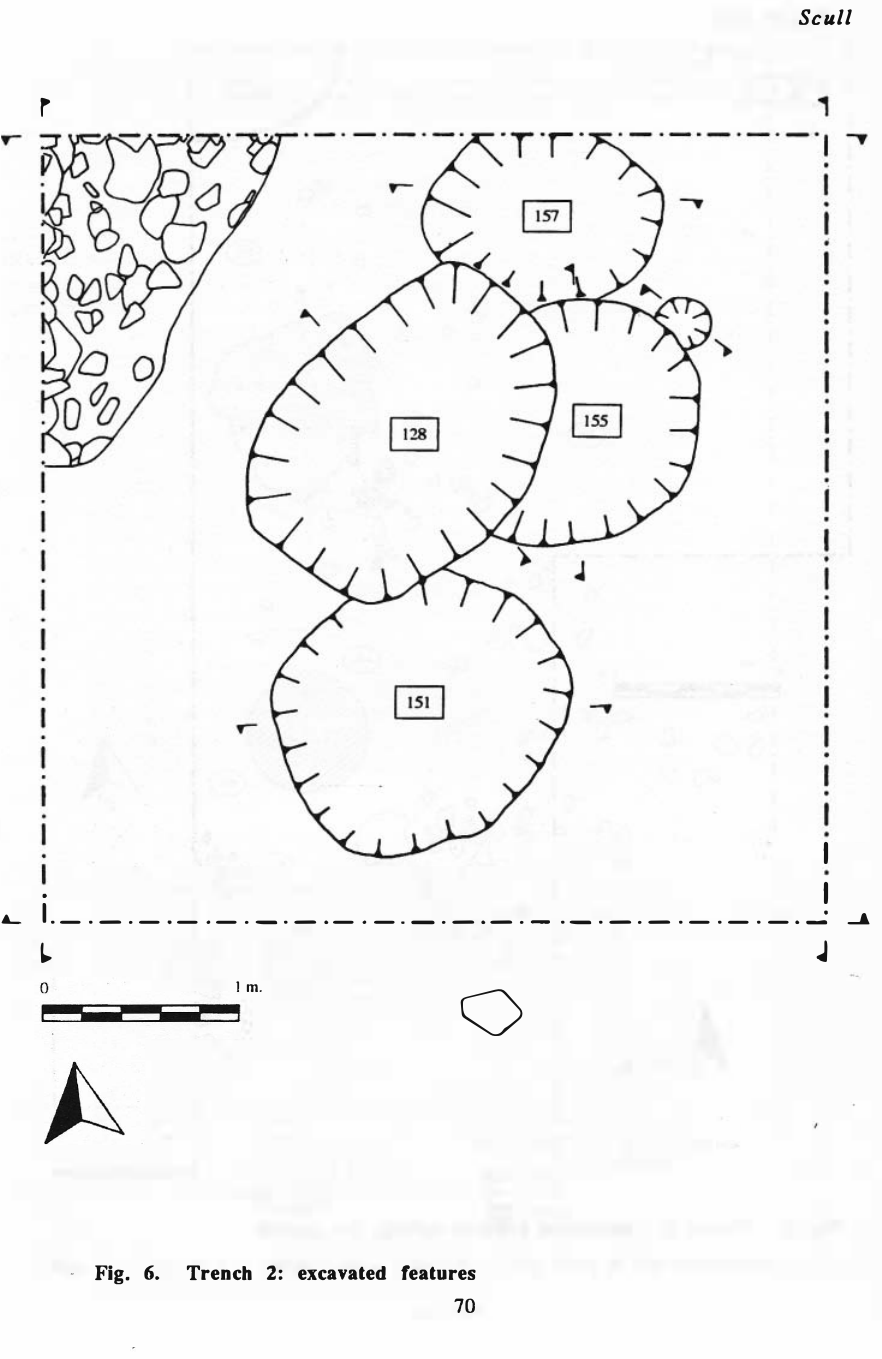
- Fig. 6. Trench 2: excavated